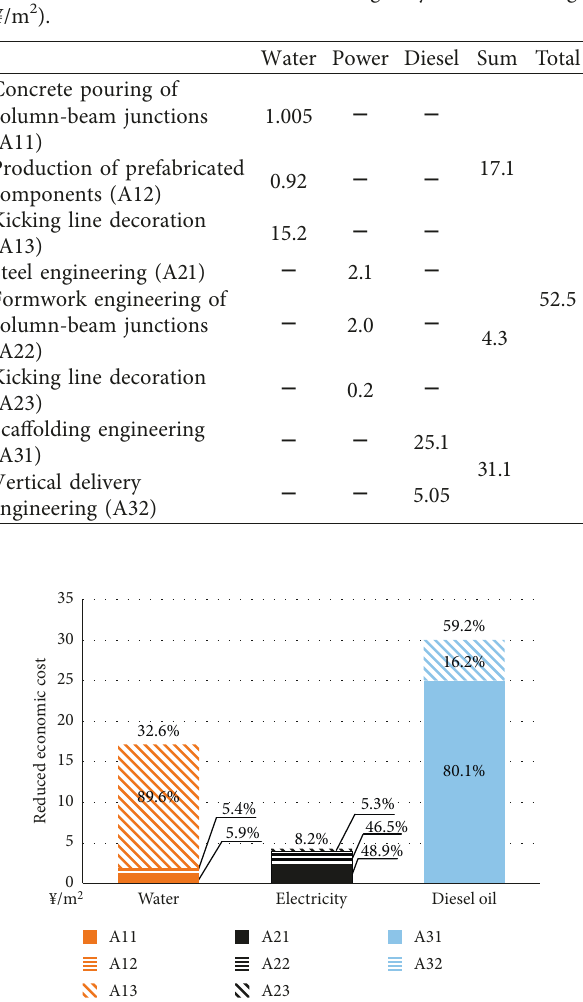
Figure 7: Economic proportions of indicators from resource- saving perspective.